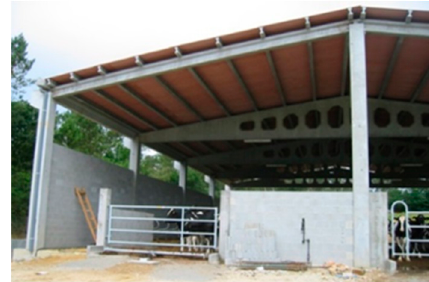
Figure 1. A typical concrete dairy farm showing pillars and beams.